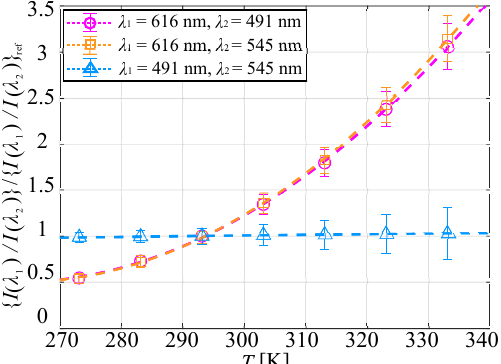
Figure 9. Normalized ratio of the emission intensities at two wavelengths plotted as a function of the temperature at P = 100